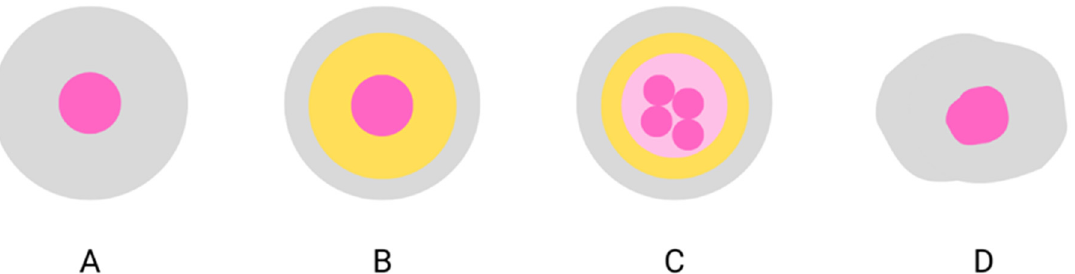
Figure 2. Schematic illustration of various morphologies formed by microencapsulation: monolayer and mononuclear microcapsule ( A ), multilayer and mononuclear microcapsule ( B ), multilayer and multinuclear microcapsule ( C ), and microparticle ( D ), own elaboration [46].